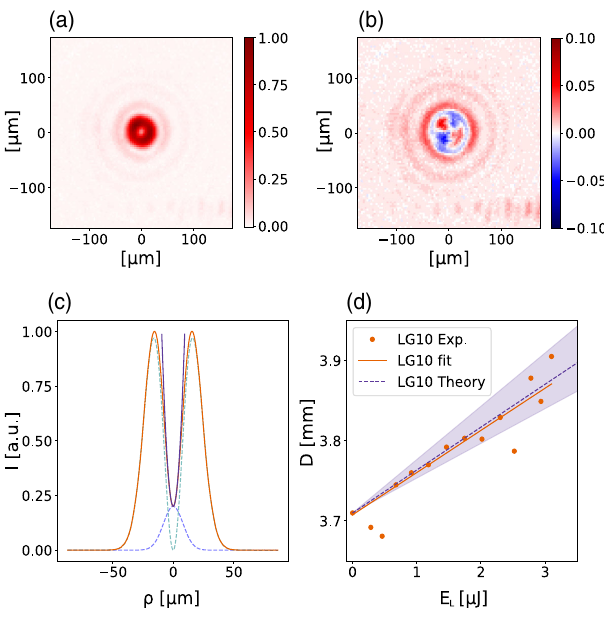
FIG. 9. (a) Spatial intensity distribution of the LG10 beam measured in the conjugate plane. (b) Residuals of a fit to the distribution. The fit function is a sum of a dominant LG10 mode and a minor LG00 mode. (c) Cross cut showing the fit (orange) and its LG10 (turquoise) and LG00 (blue) components, as well as the quadratic Taylor expansion around ρ ¼ 0 (violet). (d) Diam- eter of the electron beam at the detector as a function of the laser pulse energy, along with the theory and an error region due to our error in determining the waist of the dominant LG10